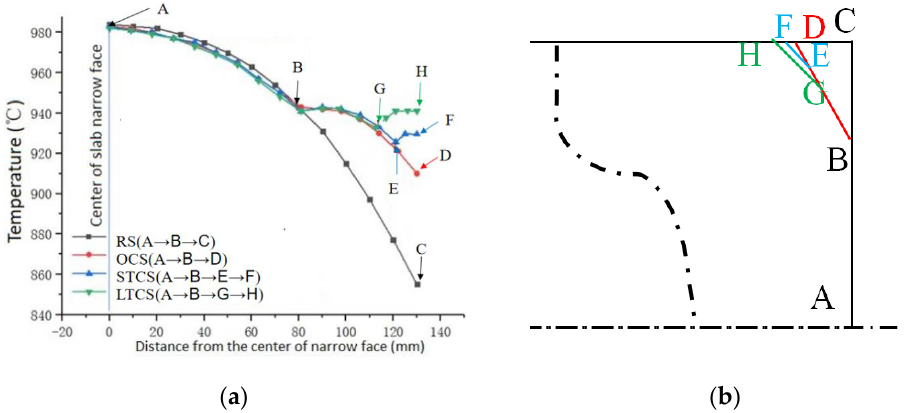
Figure 11. Temperature distribution at different heights from the narrow face’s center of various shape slabs. ( a ) Temperature distribution; ( b ) point designation diagram.